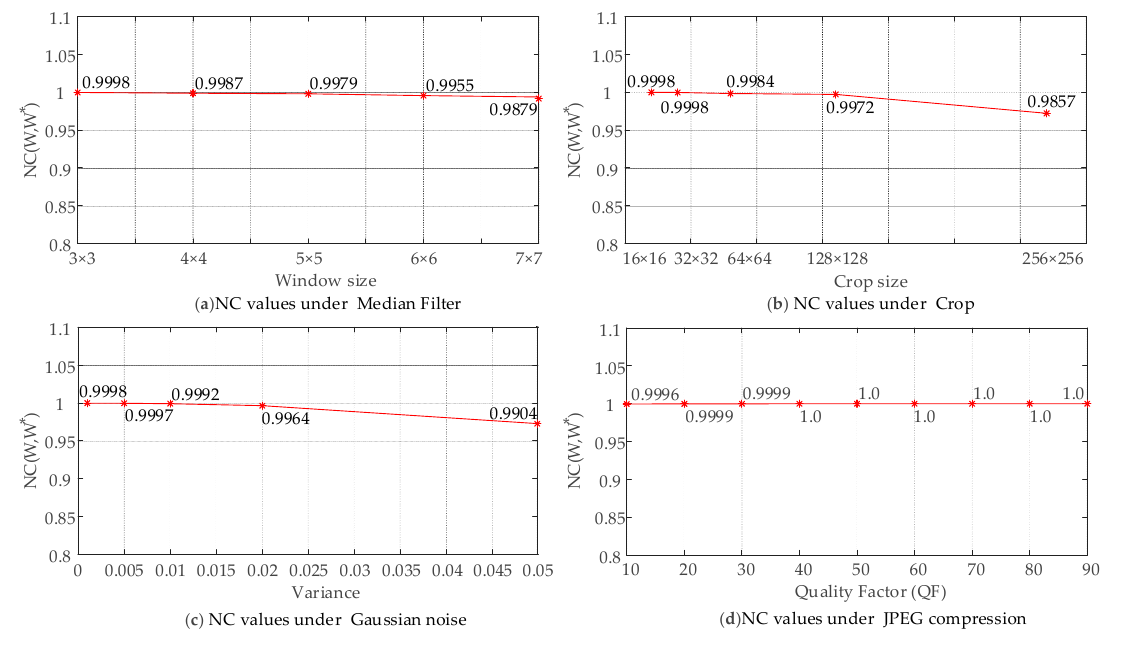
Figure 11. NC values under attacks with different parameters.